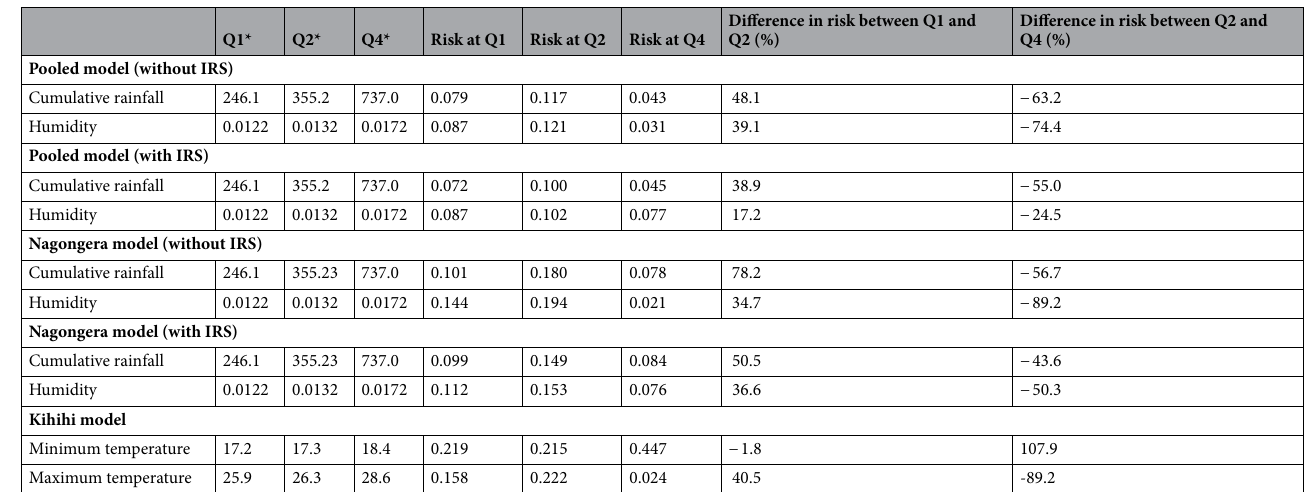
Table 6. Percentage change in risk between the 25th and the 50th, the 50th and the 100th percentile for nonlinear predictors. * Units are ˚ C for temperatures, kg.kg -1 for humidity and mm for rainfall.